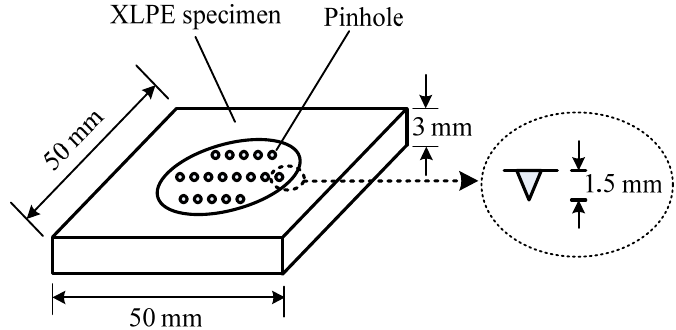
Figure 1. Configuration of the XPLE (crosslinked polyethylene) sheet specimen.